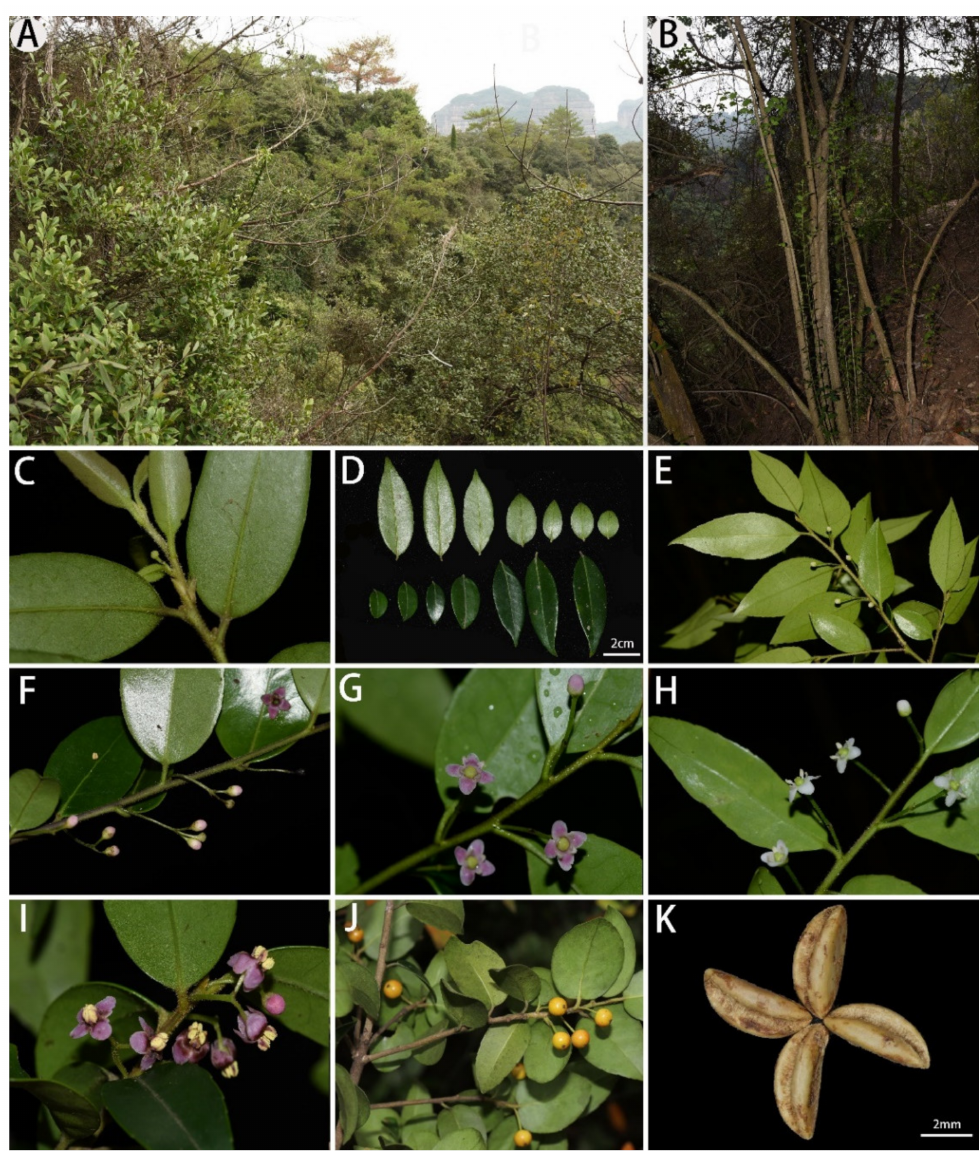
Figure 2. Ilex danxiaensis K. W. Xu & Q. Fan, sp. nov. ( A ) Habitat; ( B ) tree trunk; ( C ) annual branches; ( D ) morphological variation of leaf blades; ( E ) female flower buds; ( F ) male flower buds; ( G ) female inflorescence with pink flowers; ( H ) female inflorescence with white flowers; ( I ) male inflorescence and flowers; ( J ) infructescences and fruit; ( K )